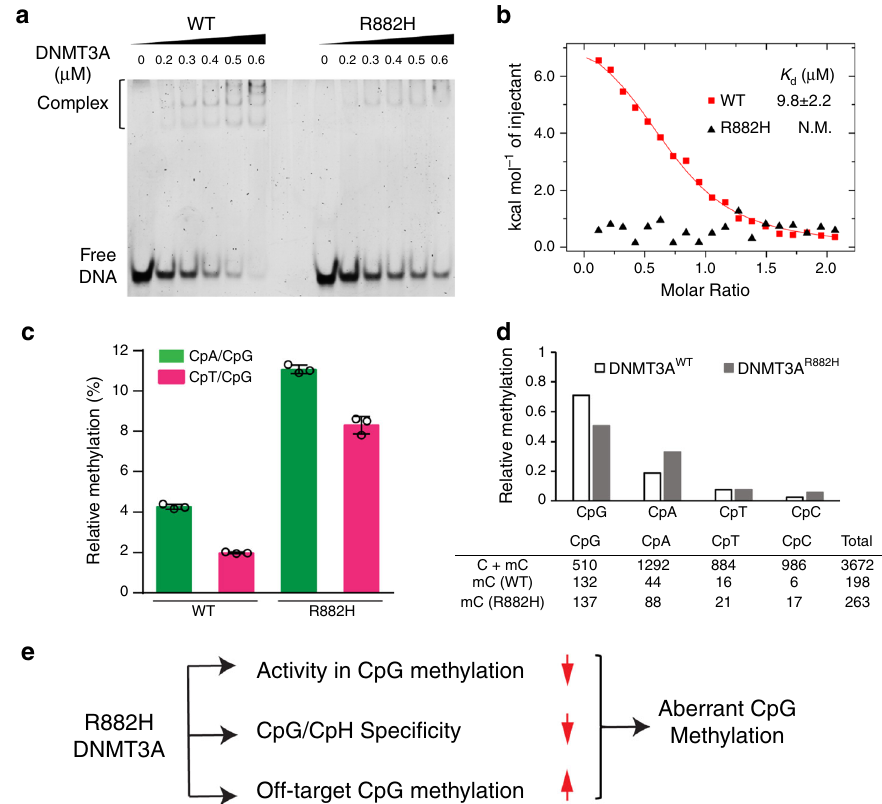
Fig. 6 Biochemical and enzymatic analyses of the DNMT3A R882H – DNA interaction. a EMSA gel image of the DNA binding activities of WT and R882H- mutated DNMT3A – DNMT3L on 36-mer (GAC) 12 DNA. Source data are provided as a Source Data fi le. The experiment was repeated once with consistent results. b ITC binding analysis of WT and R882H-mutated DNMT3A-DNMT3L on 24-mer (GAC) 8 DNA. The data and error estimate were derived from two independent experiments. N.M., not measurable. c In vitro CpG and CpH methylation of WT and R882H-mutated DNMT3A – DNMT3L, using a 36-mer DNA containing a single CpG, CpA or CpT site ( n = 3 biological replicates). The data are displayed as ratios of CpA/CpG and CpT/CpG methylation. Data are mean ± s.d. Source data are provided as a Source Data fi le. d (Top) Relative in vitro CpG and CpH methylation of WT and R882H-mutated DNMT3A – DNMT3L on a 626-bp DNA. The data are displayed as ratios of the methylation events of each indicated sequence context over total methylation events. (Bottom) Summary of total cytosine sites and methylation events in each indicated context, derived from bisul fi te sequencing analyses of 34 clones of the 626-bp DNA incubated with WT or R882H-mutated DNMT3A – DNMT3L. Source data are provided as a Source Data fi le. e Model for the impairment of CpG methylation by the DNMT3A R882H